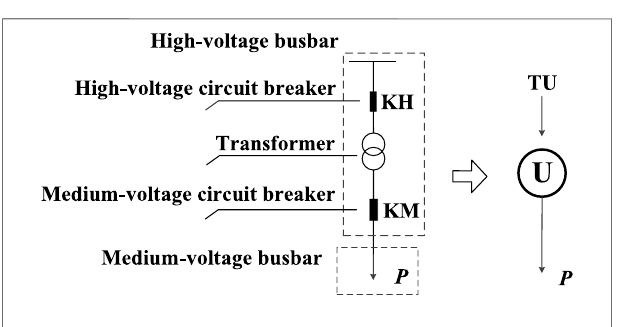
FIGURE 2 | Structure of transformer unit.